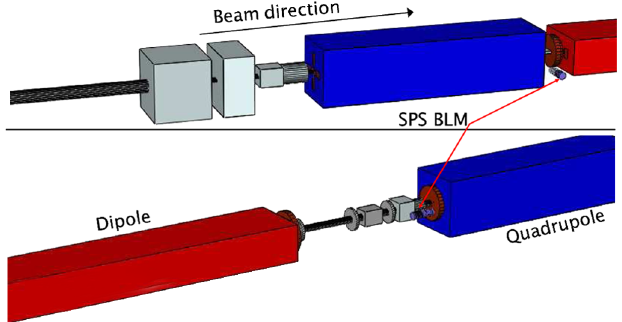
FIG. 10. (Color) The 3D geometry as implemented in FLUKA around a BLM in the vertical plane (BL520, top) and in the horizontal plane (BL521, bottom). A photo of the central part of the real geometry around BL521 is shown in Fig.